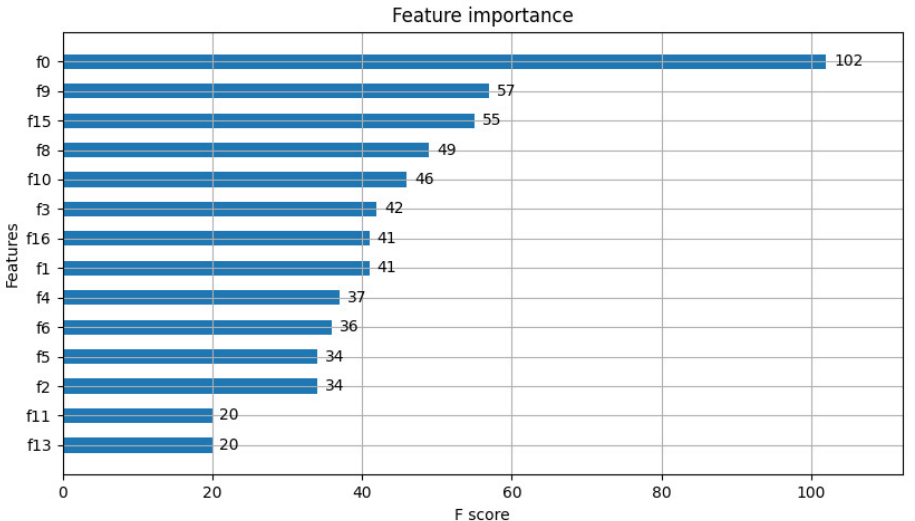
Figure 9. The feature importance of data. F0–F16 respectively represent the features, including size, count, content, font-family, top, left, width, page, height, company, pre-left, pre-size, part, pre-font, total-part, pre-top, and pre-behind. The feature importance of ‘page’, ‘part’, and ‘total-part’ is too low to show in the figure; ‘size’ means the font size, ‘count’ means the word and punctuation count, ‘content’ means the content in documents, ‘font-family’ means the font, ‘company’ means the insurance company, ‘width’ means the total width of the sentence, ‘page’ means the page number, ‘height’ means the total height of the sentence, ‘part’ means the order of the sentence in a paragraph, ‘total-part’ means the number of sentences in a paragraph, ‘top’ and ‘left’ mean the coordinate position of each sentence in the page, ‘pre-left’, ‘pre-size’, ‘pre-font’, and ‘pre-top’ are the corresponding features of the previous sentence. (‘pre-left’, ‘pre-top’ and so on are just the names we call the features). ‘pre-behind’ means the distance from page bottom of the previous sentence. The previous sentence features are incorporated into context feature